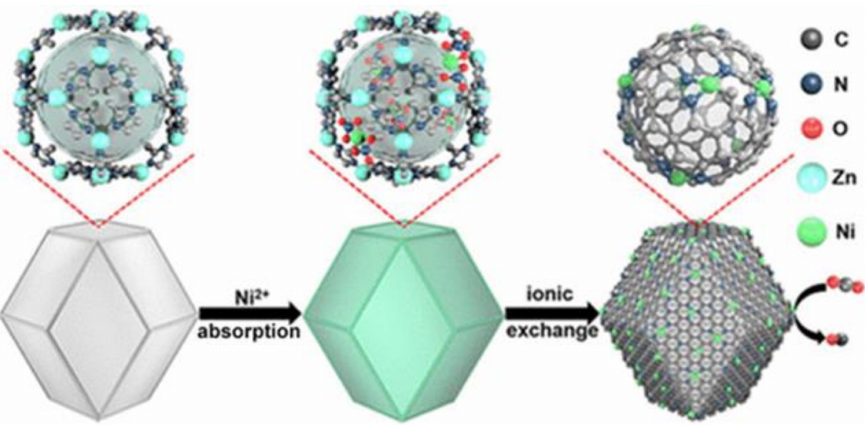
Figure 6. Schematic illustration of the synthesis of Ni SAs/N-C through a ZIF-assisted method. Reprinted with permission from Ref. [56]. Copyright 2022 American Chemical